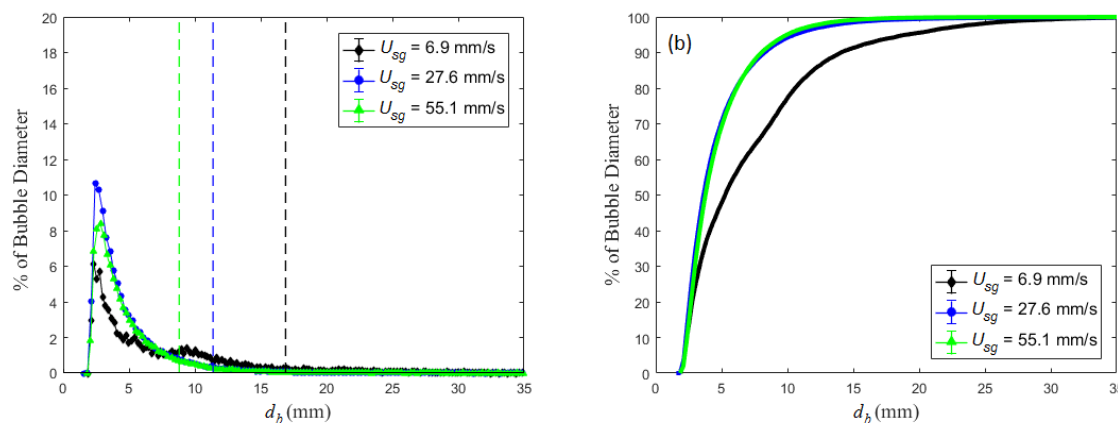
Figure 5. ( a ) Probability density functions (PDF) and ( b ) cumulative density function (CDF) of bubble size ( d b ) for the same conditions shown in Figure 4. The PDF/CDF for each U sg was determined from counting at least 10,000 bubbles. Dashed lines in ( a ) correspond to the d 32 values for each condition ( P m = 600 kPa, T c = 21 ± 1 °C, D = 102 mm, d inj = 1.6 mm).